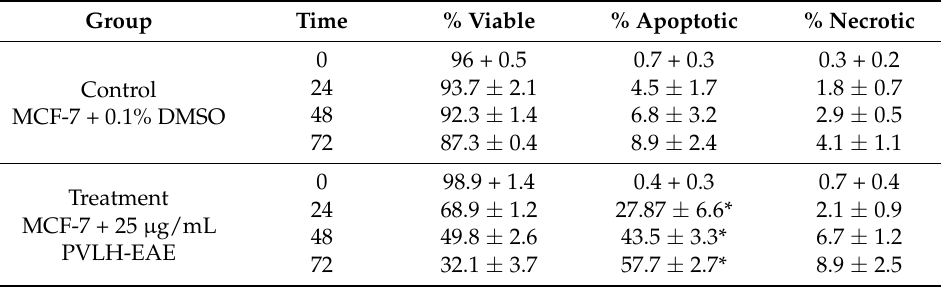
Table 2. AO/PI staining of MCF-7 cells.